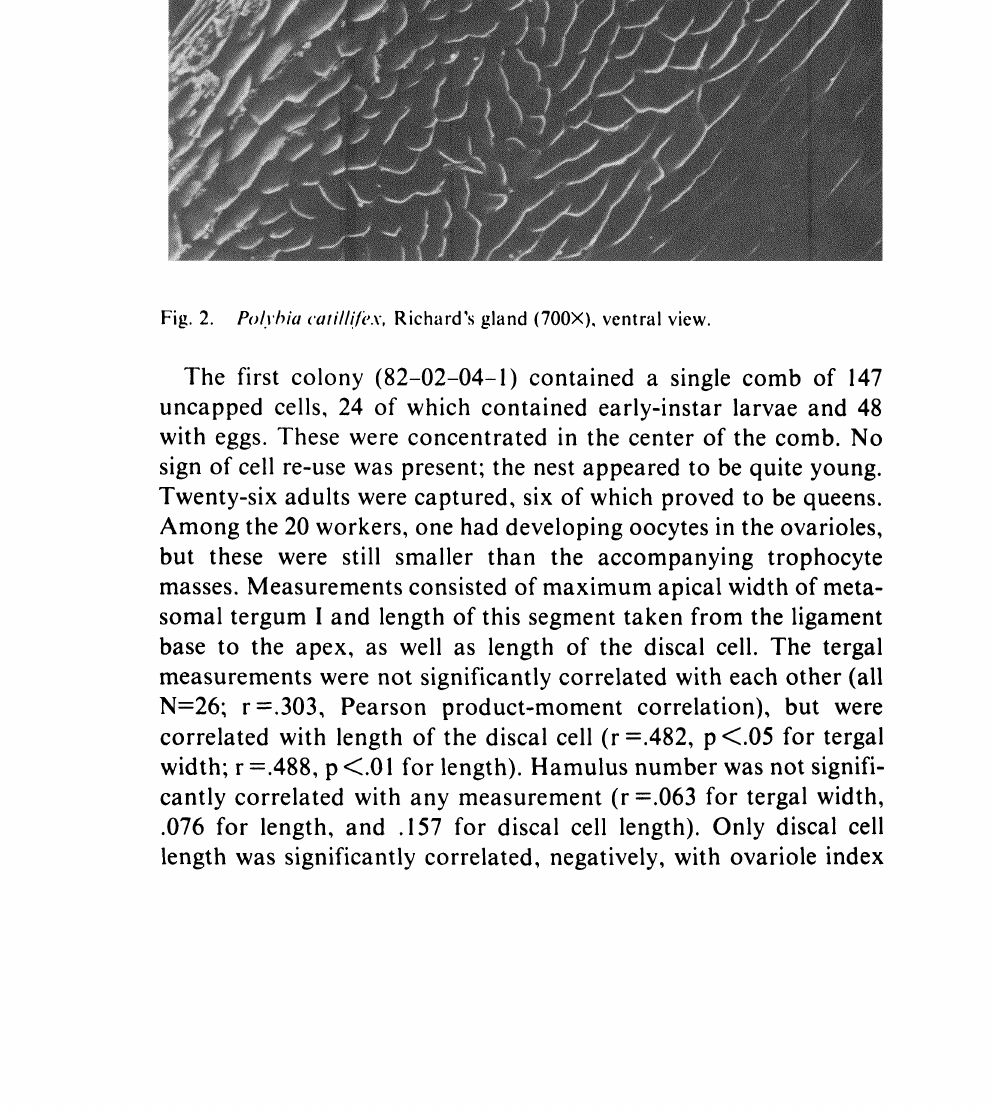
Fig. 2. Polvtia catill(fe.v, Richard’s gland (700), ventral